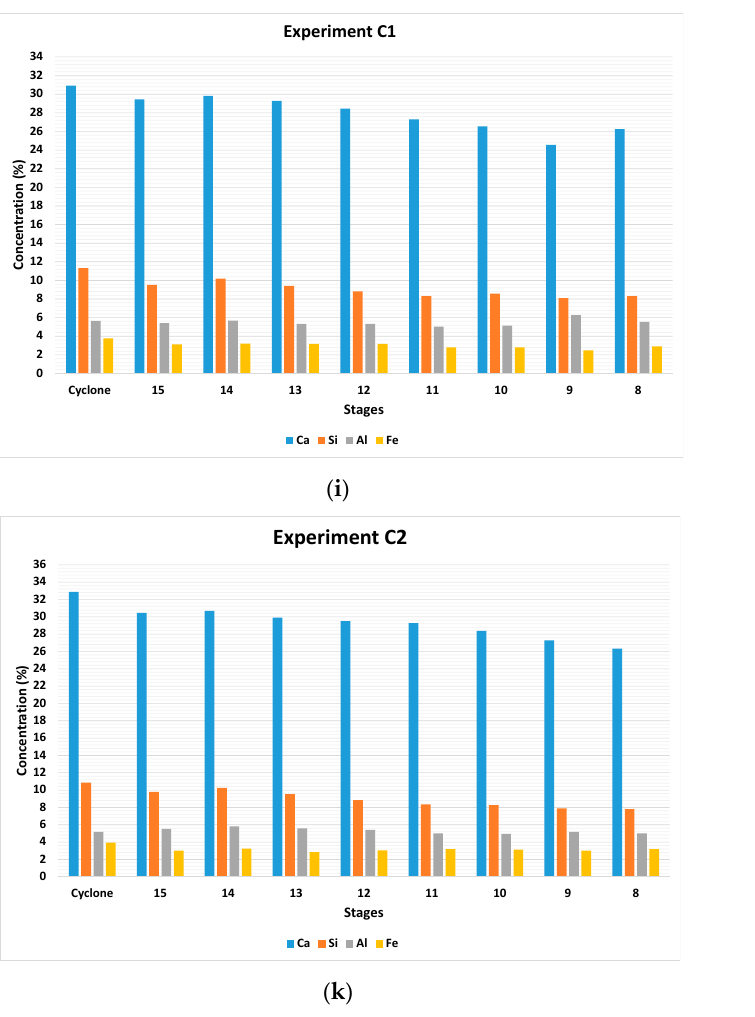
Figure 7. Elemental concentration (wt%) for fly ash particles for stages Cyclone, 15, 14, 13, 12, 11, 10, 9, 8 in bar chart for elements Ca, Si, Al, Fe and spider chart for elements S, Mg, K, Cu, Zn, Ti, Na for experiment: ( a ) A1; ( b ) A1; ( c ) A2; ( d ) A2; ( e ) B1; ( f ) B1; ( g ) B2; ( h ) B2; ( i ) C1; ( j ) C1; ( k ) C2; ( l )